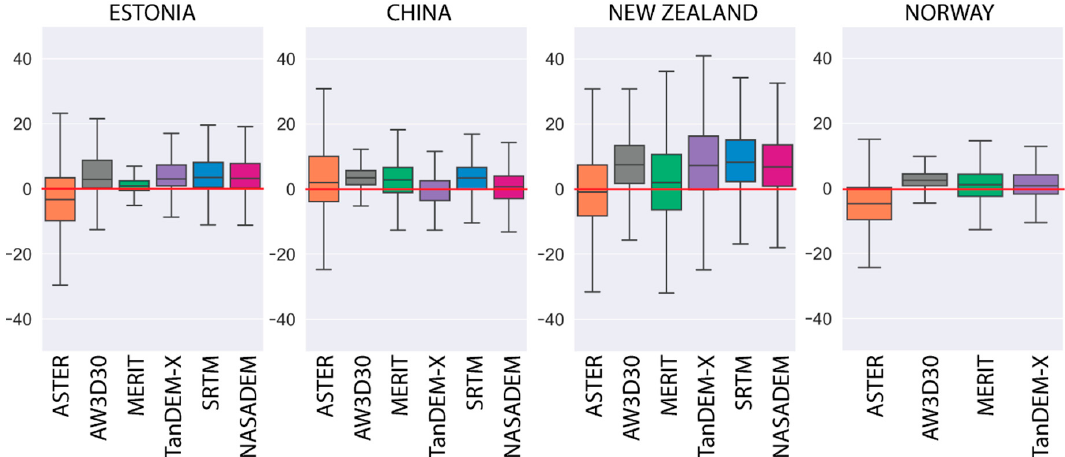
Figure 2. Box plots of the errors for all cover types combined in the global DEM models for the four study areas. SRTM data were not available for the Norway area because of its high latitude. The central horizontal line in the box marks the median; the boxes show the interquartile range (25th to 75th percentile), and the whiskers show 1.5 times the interquartile range.